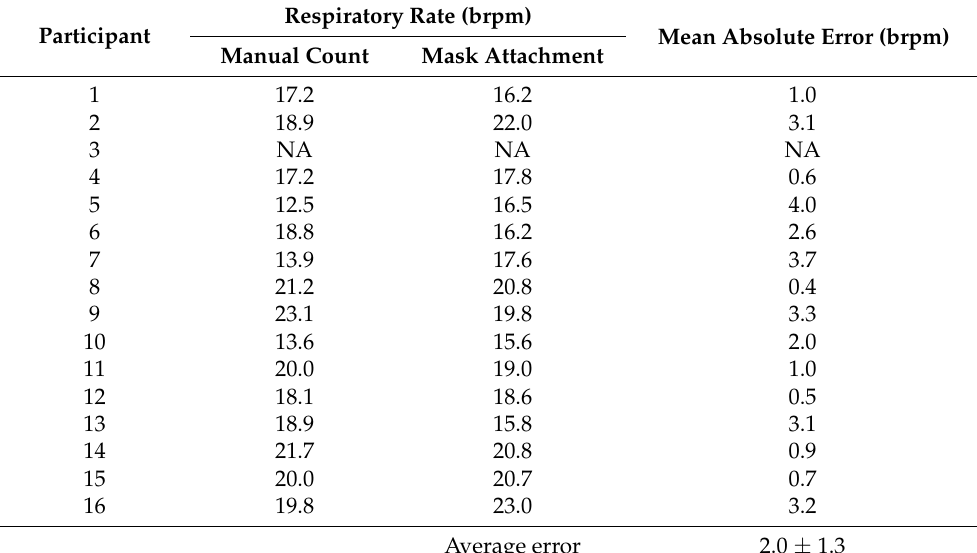
Table 2. Comparison of resting respiratory rate between the mask attachment and manual counting for spontaneous